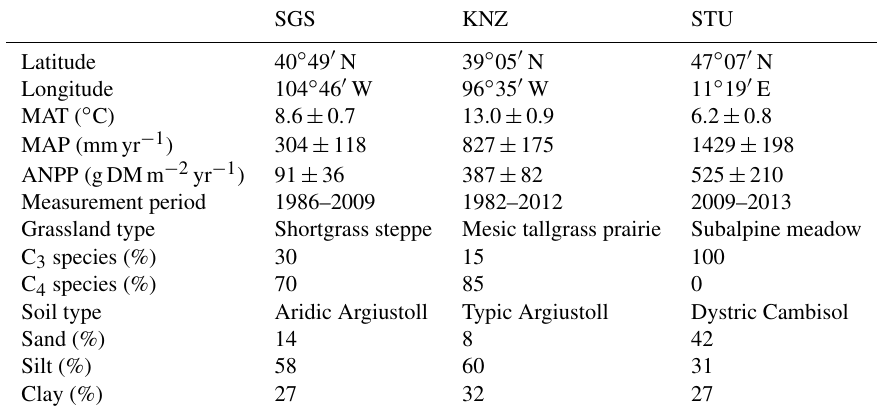
Table 1. Key plant, soil and climate characteristics of the three grassland sites. MAT, mean annual temperature; and MAP, mean annual precipitation. MAT and MAP are based on the periods for the three sites with ANPP